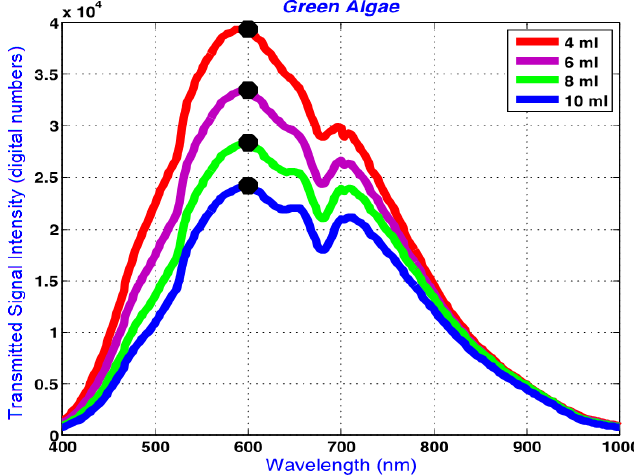
Figure 8. Average raw spectra from green algae samples (from set 3 in Table 1; sparsely grown) with 4, 6, 8 and 10 mL. Data points at 600 nm are selected and substituted in the trasmision equation based on Beer-Lambert Law.